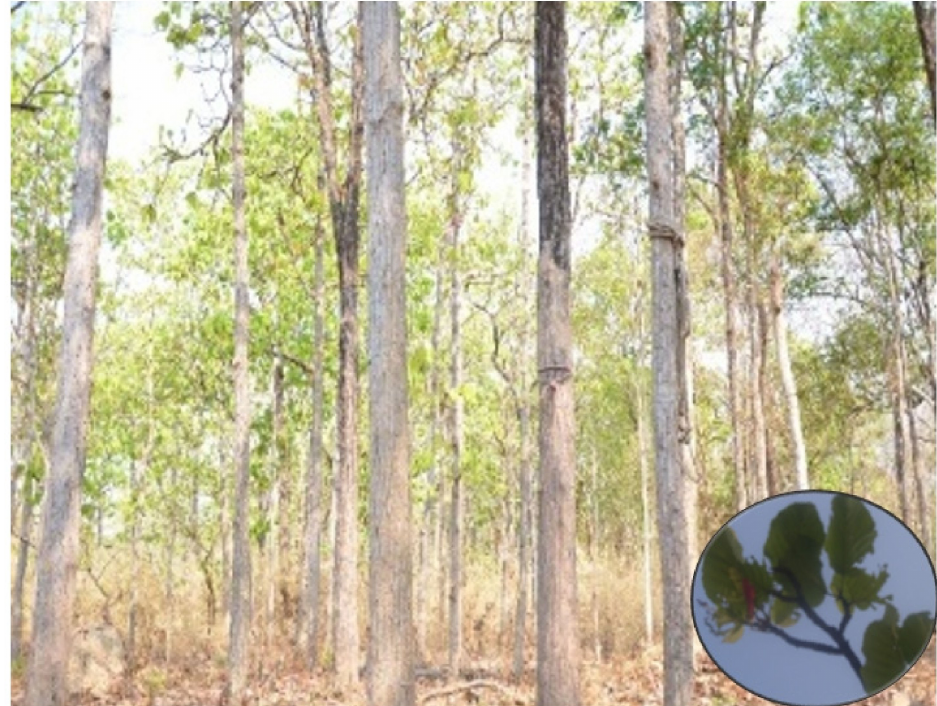
Figure A1. Dipterocarpus tuberculatus .